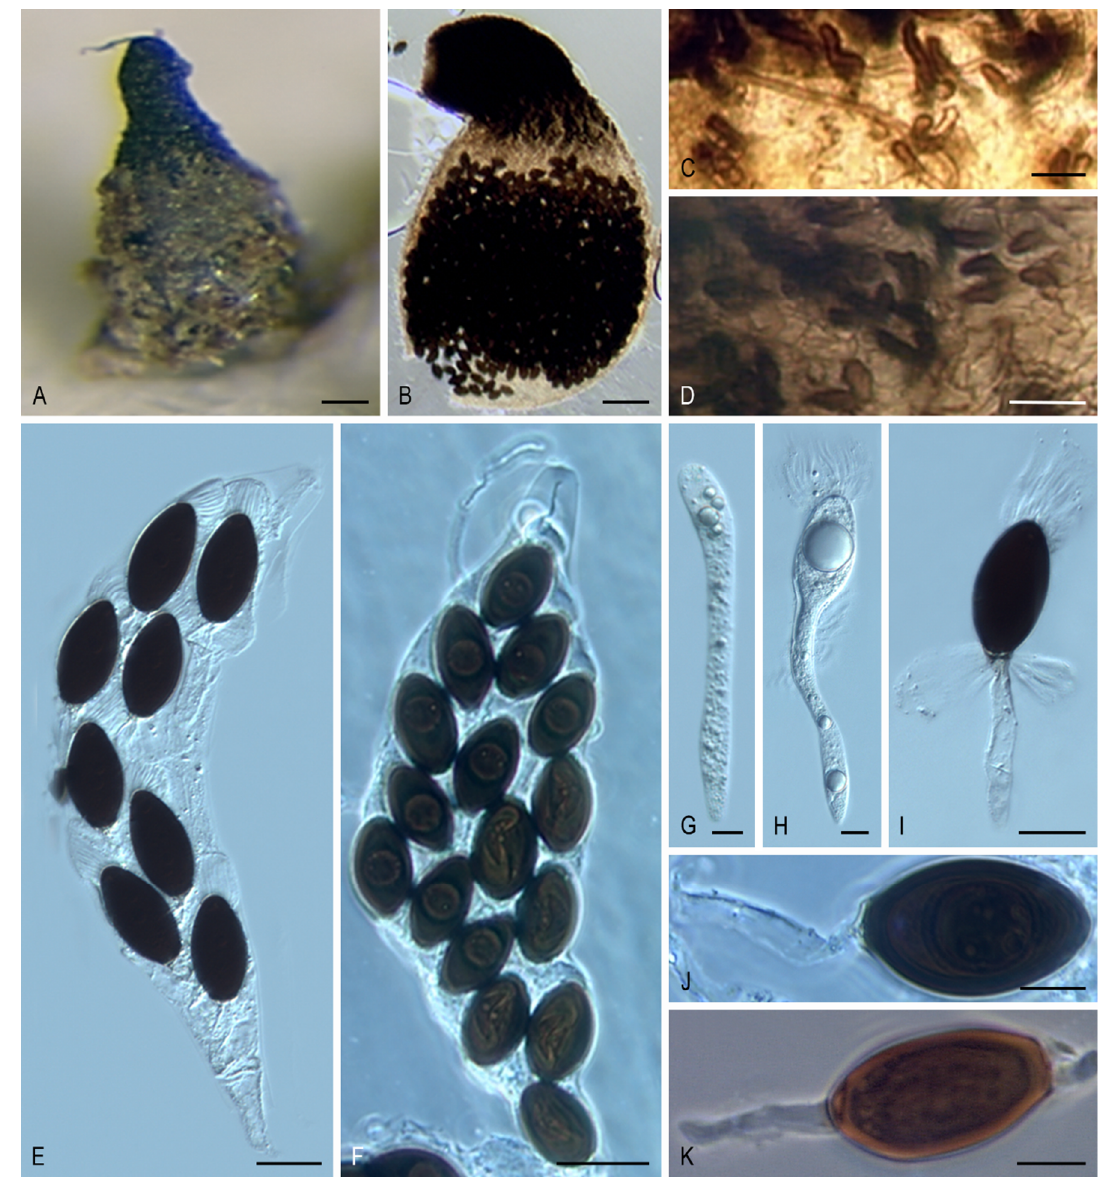
Figure 5. Morphology of Rhypophila . Ascoma. ( A ) Rhypophila pleiospora LyRS9223.1. ( B ) Rhypophila myriospora CBS 115804. Elongated tubercles at the neck. ( C ) Rhypophila pleiospora LyRS9223.1. ( D ) Rhypophila myriospora CBS 115804. Asci. ( E ) Rhypophila decipiens LyRS8109.2. ( F ) Rhypophila pleiospora LyRS9223.1. Immatured ascospores. ( G , H ) Rhypophila decipiens LyRS8109.2. Different ascospore morphologies. ( I ) Rhypophila decipiens LyRS8109.2. ( J ) Rhypophila pleiospora LyRS9223.1. ( K ) Rhypophila myriospora CBS 115804. Bars: ( A , B ) = 100 µm; ( C , D ) = 15 µm; ( E,F ) = 25 µm; ( G , H , J , K ) = 10 µm; ( I ) = 20 µm.